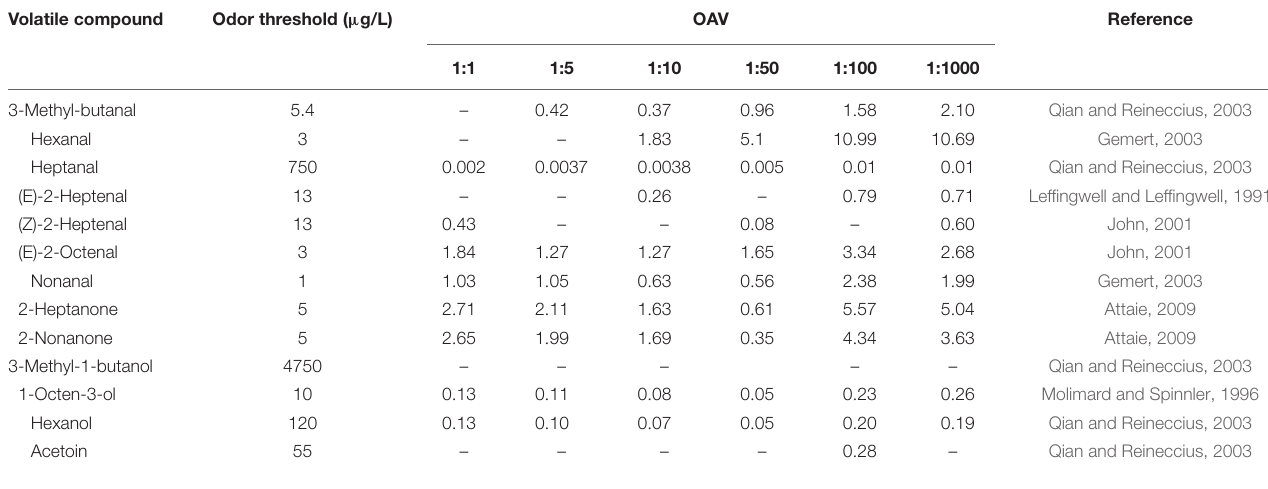
TABLE 3 | Odor activity values (OAVs) of the compounds produced in milk fermented with 1:100 and 1:1000 ratios of L. plantarum P-8 to S. thermophilus (compared with a 1:1000 ratio of L. delbrueckii subsp. bulgaricus to S. thermophilus